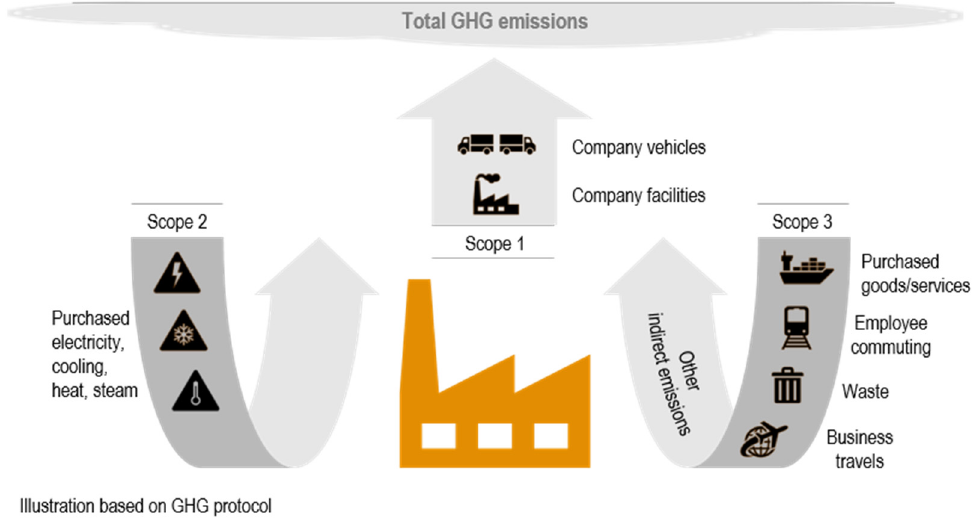
Figure 4. Carbon footprint assessment [38,52].